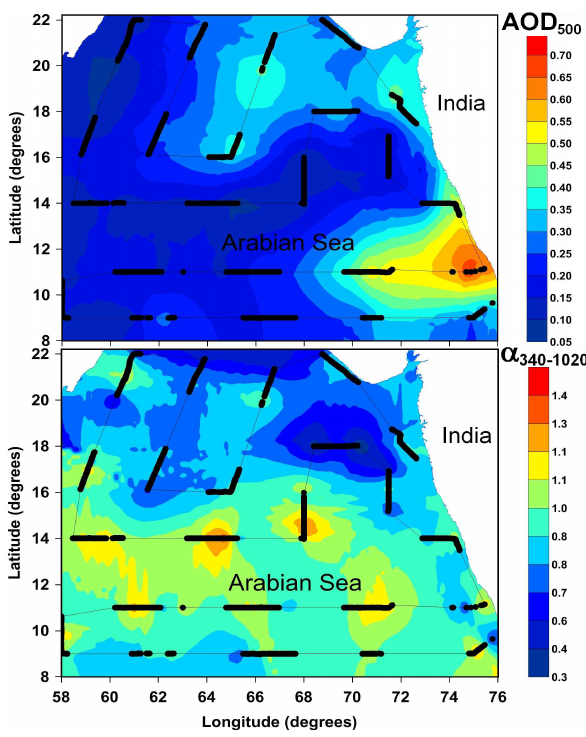
Fig. 8. Spatial distribution of the AOD 500 (top) and α 340 − 1020 (bot- tom) values regarding the whole set of measurements over the AS region. The ship track is shown in black line, while the positions of the sun photometric measurements are indicated with dots. Note that the sun photometric measurements were taken only in daytime and under cloudfree